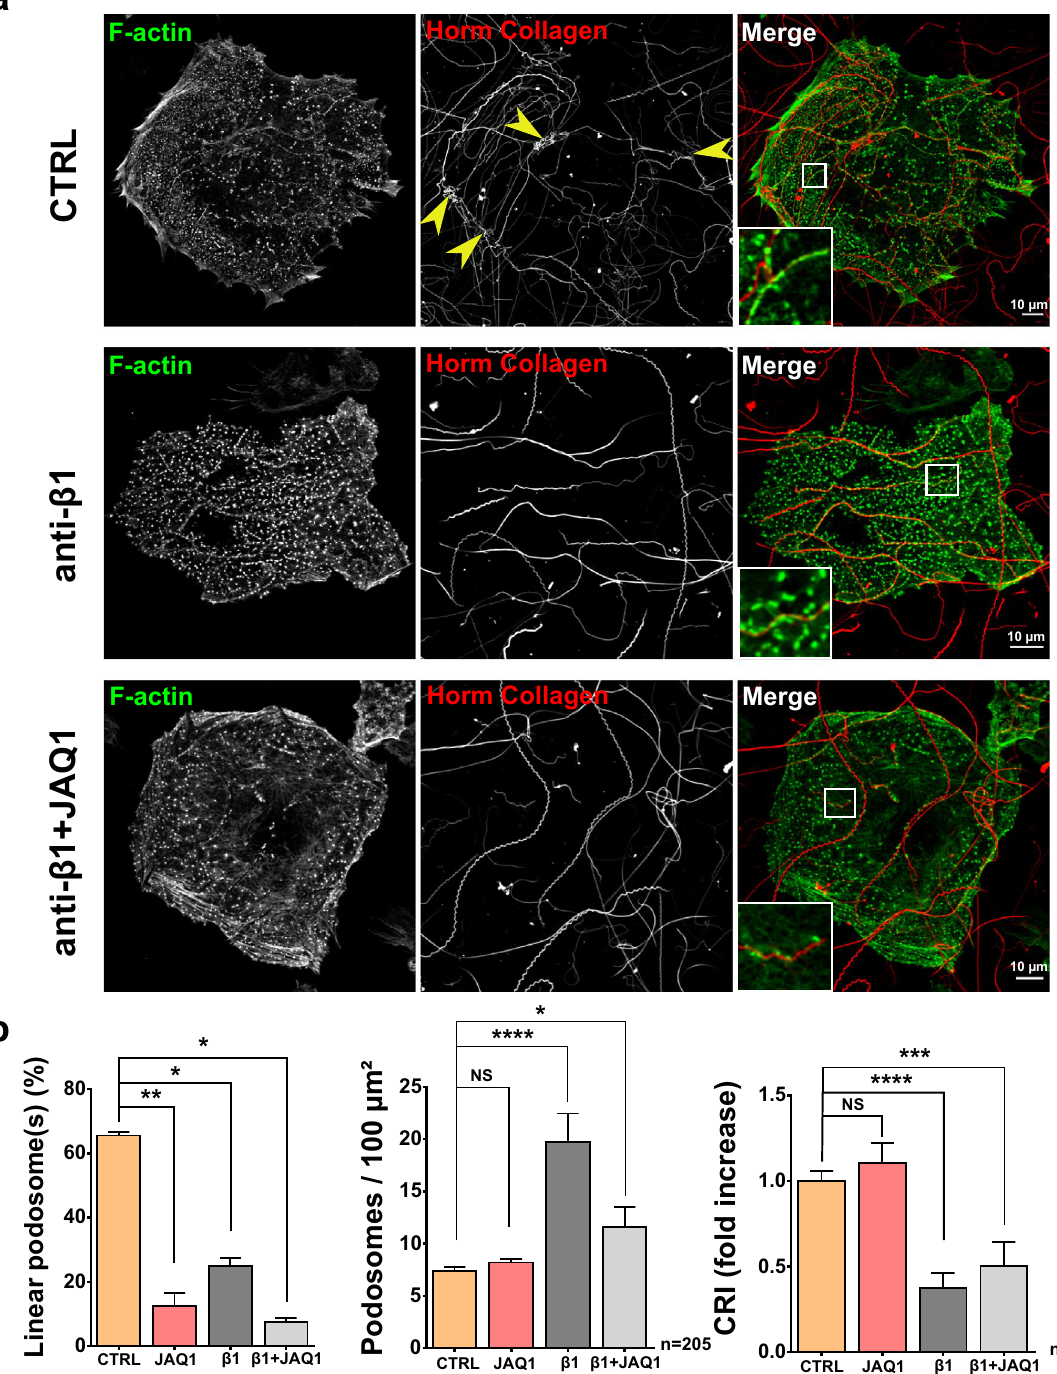
Figure 8. Inactivation of both GPVI and the ß1 integrin dramatically impairs linear podosome formation and traction of collagen I. ( a ) Representative confocal image of mature MKs cultured for 6 h on 100 µg/ml Horm Collagen, prior to fixation and staining for F-actin (green). Control D3MKs (CTRL) and D3MKs pretreated with a blocking ß1-integrin antibody (Purified NA/LE Hamster anti-rat CD29, 10 µg/ml) with or without JAQ1 (GPVI blocking antibody) were fixed and stained for F-actin (green). Yellow arrows indicate Collagen tangled clumps. Scale bar = 10 µm. ( b ) Quantification of linear podosomes or dot-like podosomes (podosomes) density (for 100 µm 2 ) and CRI in the indicated cells. Values (mean ± S.E.M.) are from 3 independent